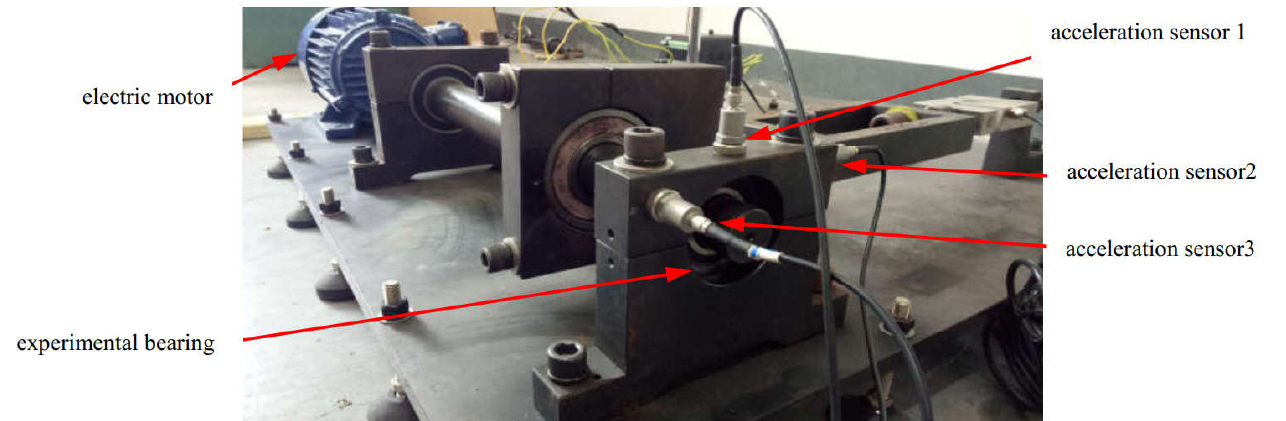
Figure 3. Schematic diagram of rolling bearing test rig.